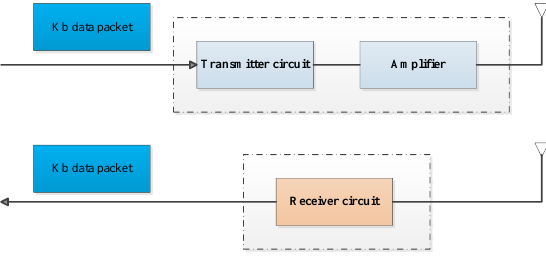
Figure 1. The energy consumption model.